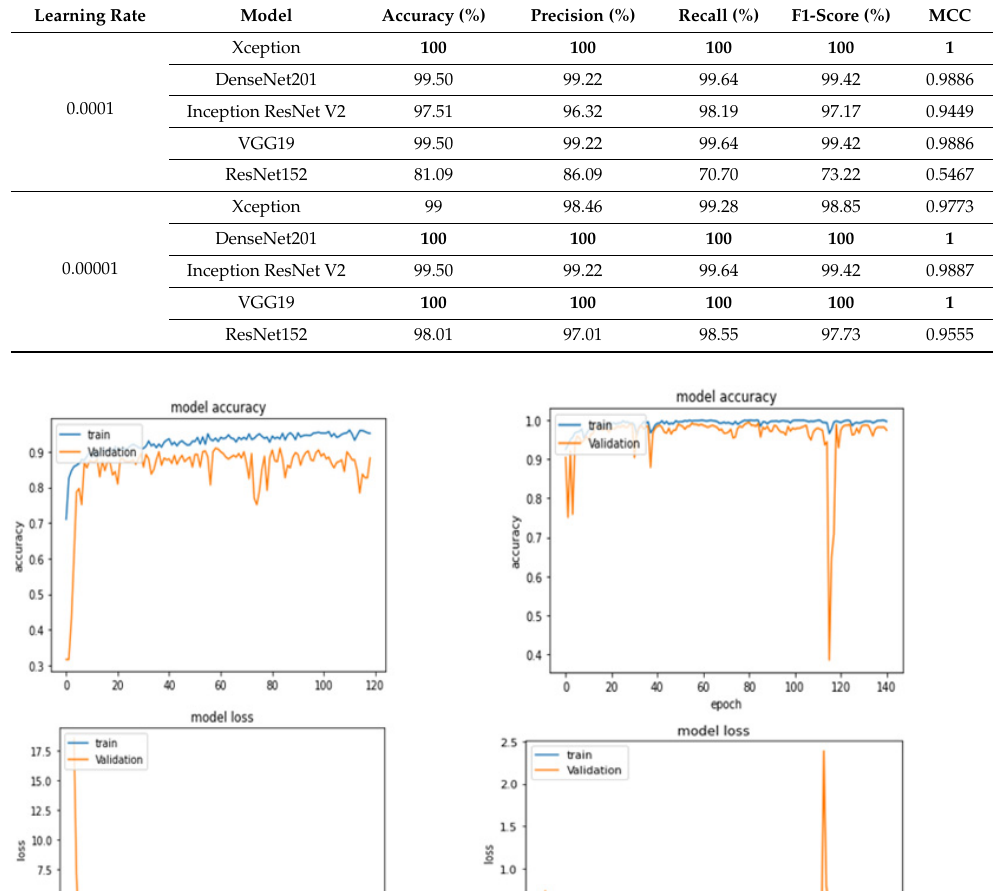
Table 5. Results of 40 × magnification factor in binary classification mode; the highest results are shown in bold.